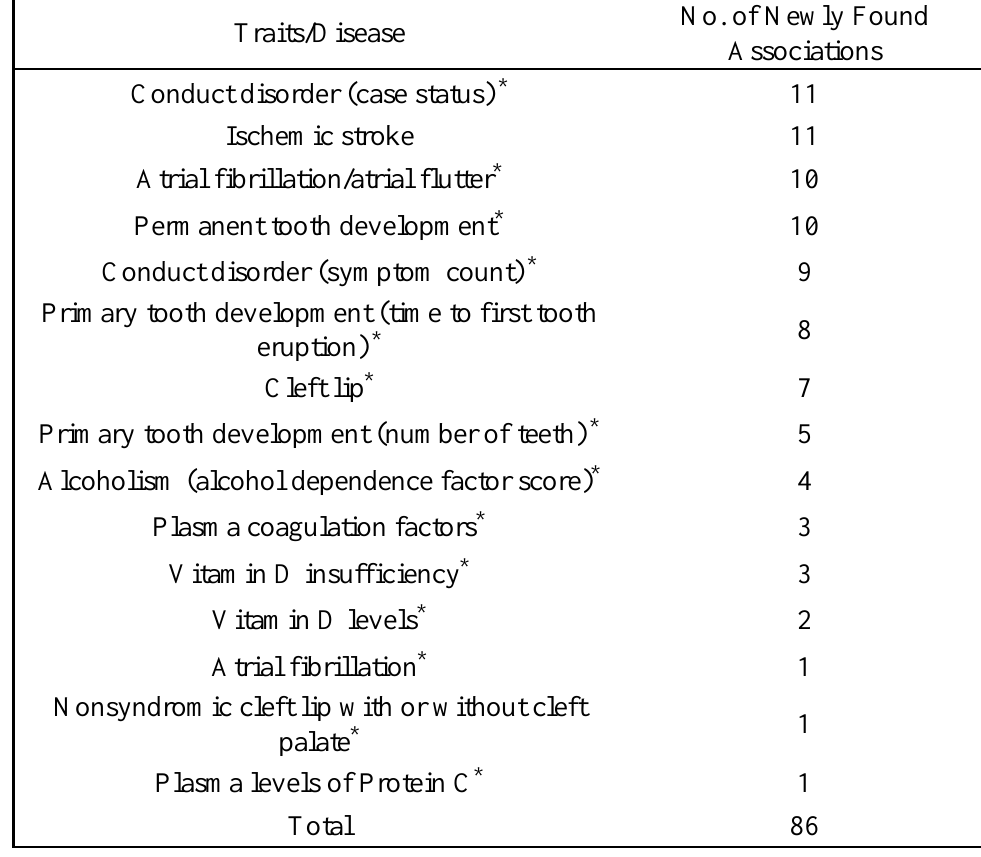
Table 2: New associations obtained from bi-clustering editing. The items with “*” come from NHGRI dataset while the remaining emerge from Johnson et al.’s online